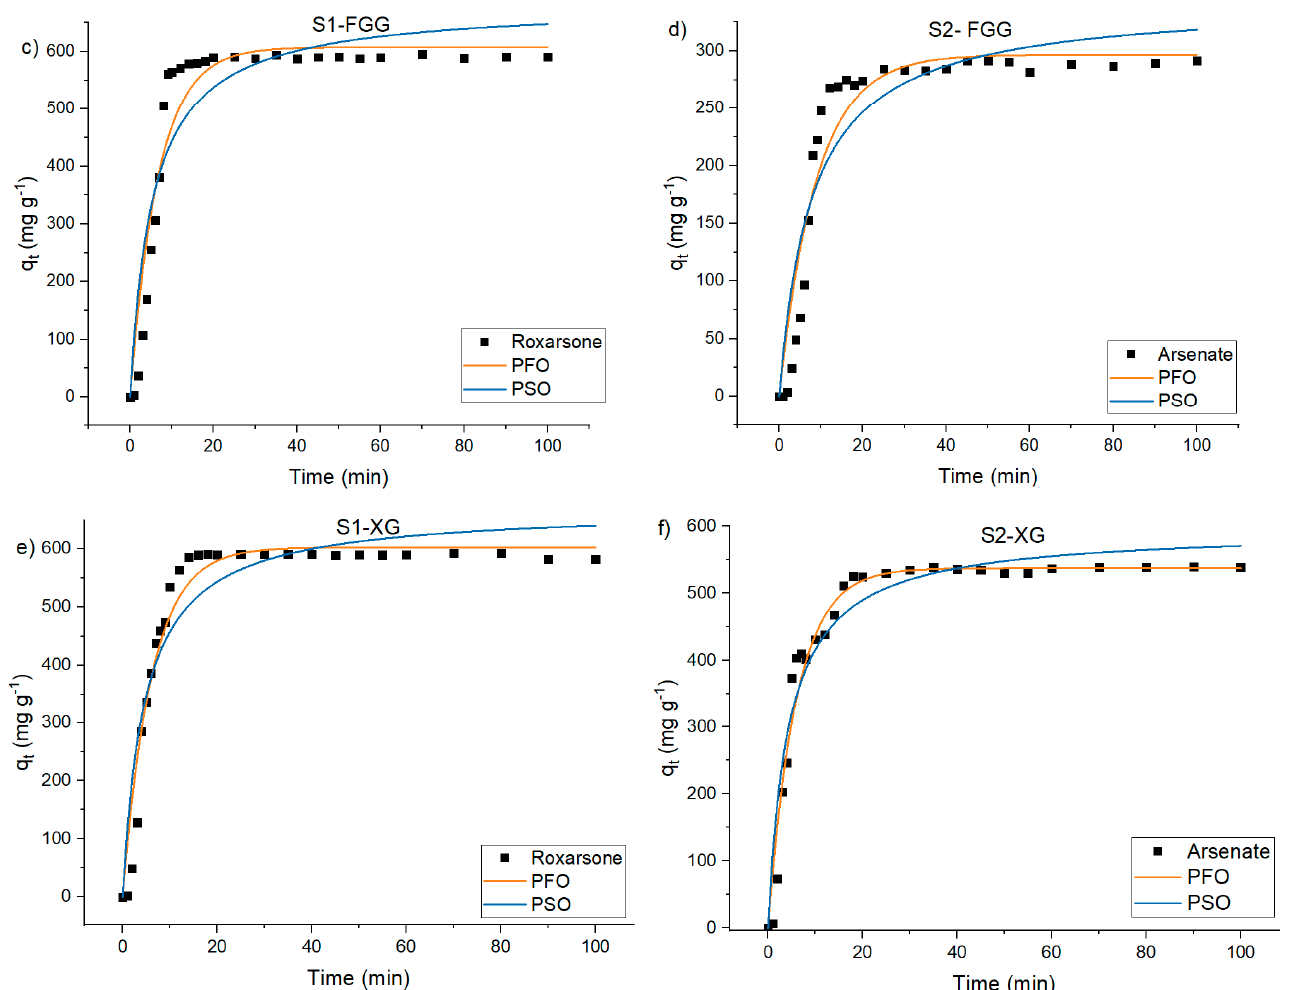
Figure 5. Kinetic profiles for the adsorption at 295 K: S1 -FSG ( a ), S2 -FSG ( b ), S1 -FGG ( c ), S2 -FGG ( d ), S1 -XG ( e ), S2 -XG ( f ), PFO and PSO kinetic-model best-fit results. ( d ), S1 -XG ( e ), S2 -XG ( f ), PFO and PSO kinetic-model best-fit